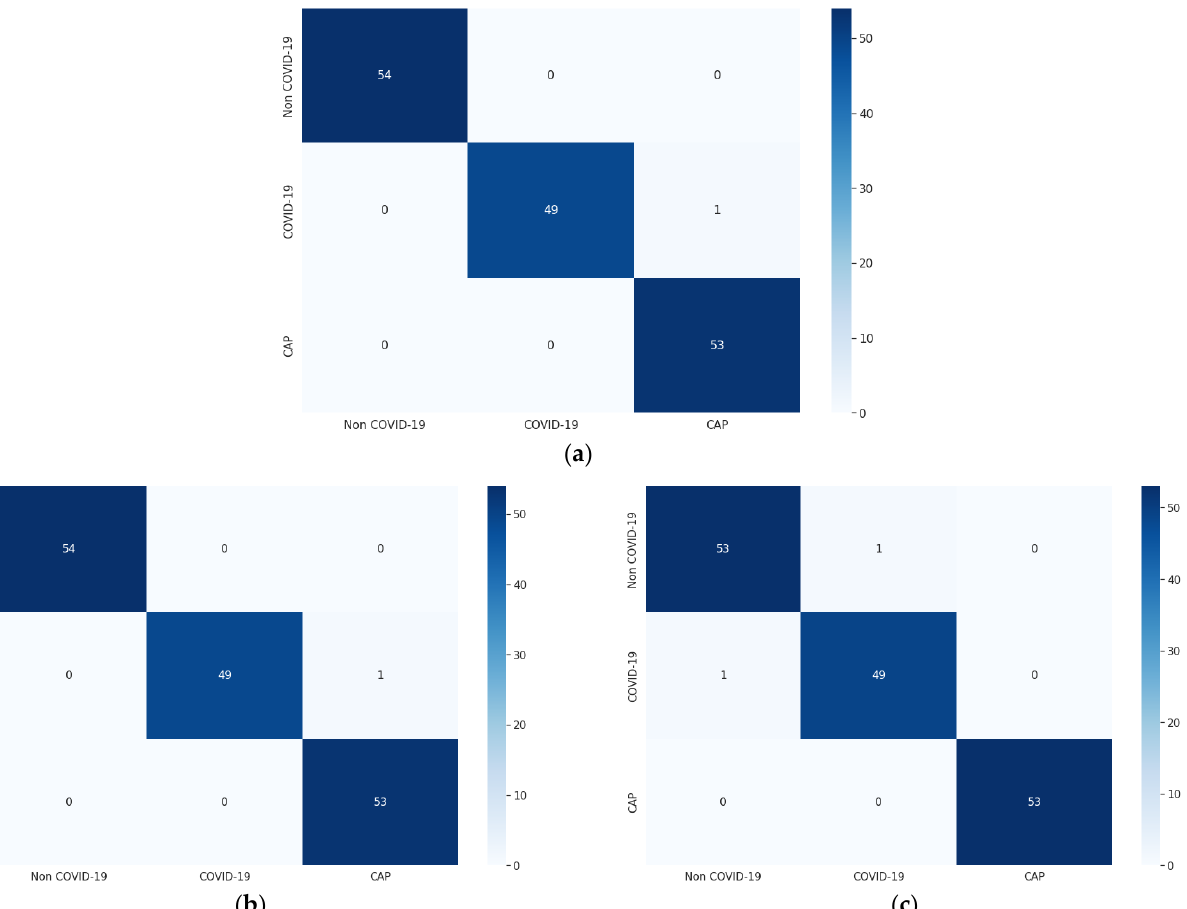
Figure 6. Confusion matrix for CT images using LDDNet: ( a ) Adam optimizer, ( b ) Nadam optimizer, and ( c ) SGD optimizer.